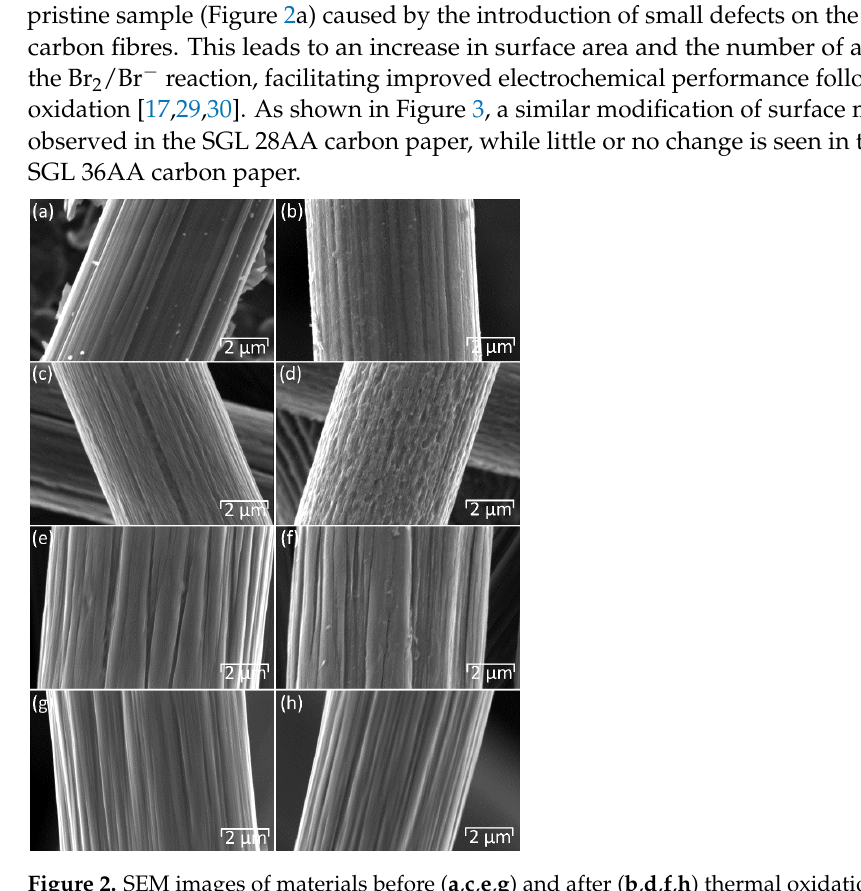
Figure 3. SEM images of materials before ( a , c ) and after ( b , d ) thermal oxidation at 550 °C for 5 h: ( a , b ) 28AA, ( c , d ) 36AA. Magnification 20 k. Accelerating voltage 5 kV. Working distance 14 mm. The change in surface morphology is particularly pronounced for the MGL370 moulded graphite laminate, which exhibits surface defects in the as-received condition